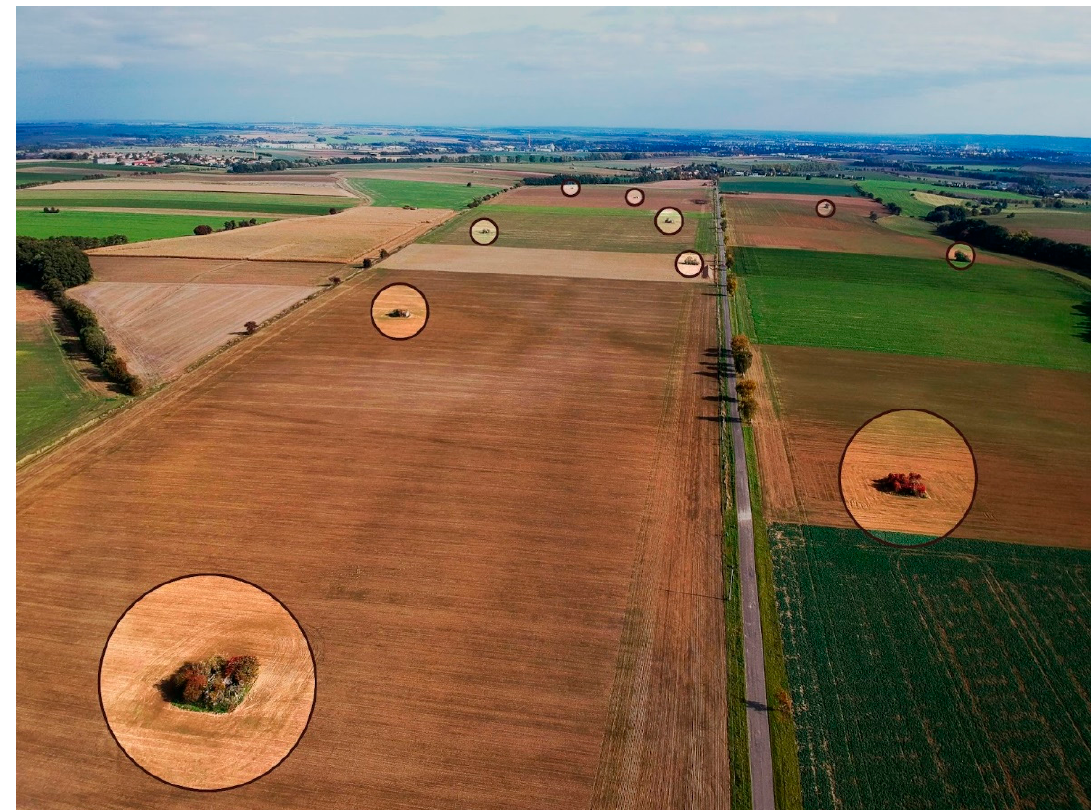
Figure 2. Visible line of Czechoslovak fortification complex (A-CEFs) in part of Moravian-Silesian Region, on part of the section ‘Milostovice’; photographed from drone.